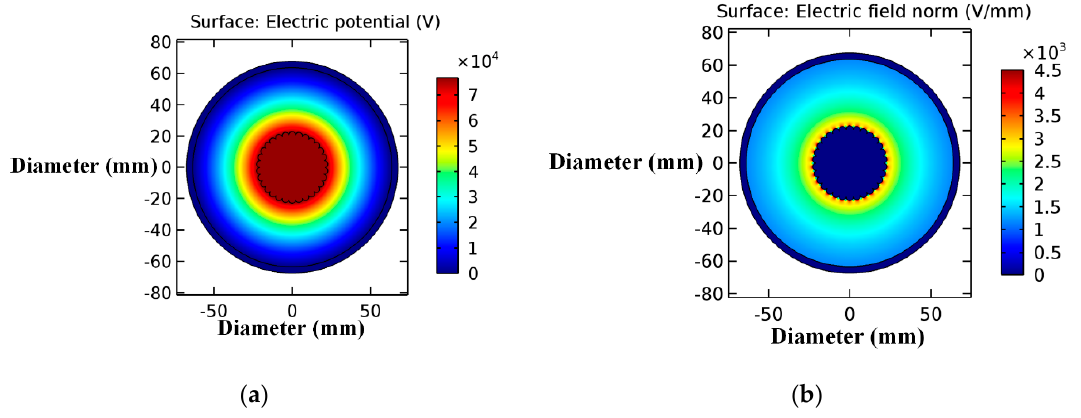
Figure 3. ( a ) Potential difference and ( b ) field distribution apropos of the proposed pliable GIL regarding specimen 2 of Table 2.